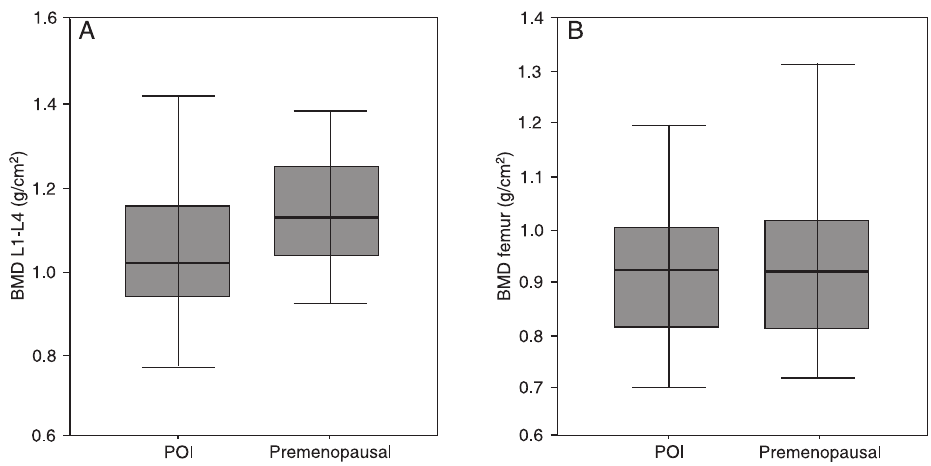
Figure 1. Bone mineral density (BMD) of the primary ovarian insufficiency (POI, N = 32) and premeno - pausal reference (N = 25) groups. A , L1-L4 lumbar bone mineral density (*P = 0.040; Student t -test). B , Femoral bone mineral density.